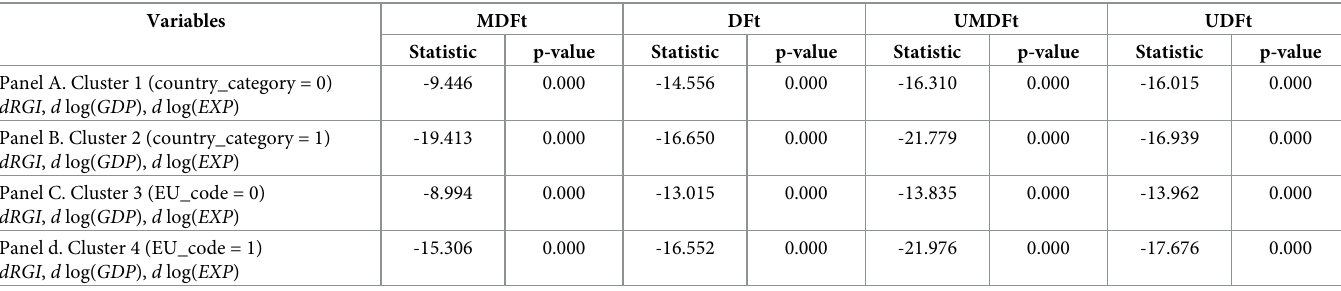
categories to ensure the statistical credibility of the model. When selecting the optimal lag order, three information criterias of MBIC, MAIC, and MQIC are generally used for judg- ment, and the minimum value of information criterion is the optimal lag order. When the three results are inconsistent, it is generally considered that the MBIC/MQIC standard is better than MAIC. The test results are shown in Table 8. It can be seen from Table 8, when the Panel VAR model is lagged by 1st-order, the p values of J statistic are less than 0.05, indicating that the optimal lag length of the model is 1. In addi- tion, the lagged first-order values of MBIC, MAIC, and MQIC are the smallest, so it is reason- able to choose the lagged first-order of the Panel VAR model to study the dynamic impact of reverse globalization on economic scale and export trade in different country categories. After eliminating the fixed effect and country-year dummy variable, this paper considers the robustness of GMM, combines with 2000 reps of Monte-Carlo simulation to estimate the Table 7. Results of the cointegration test at the country